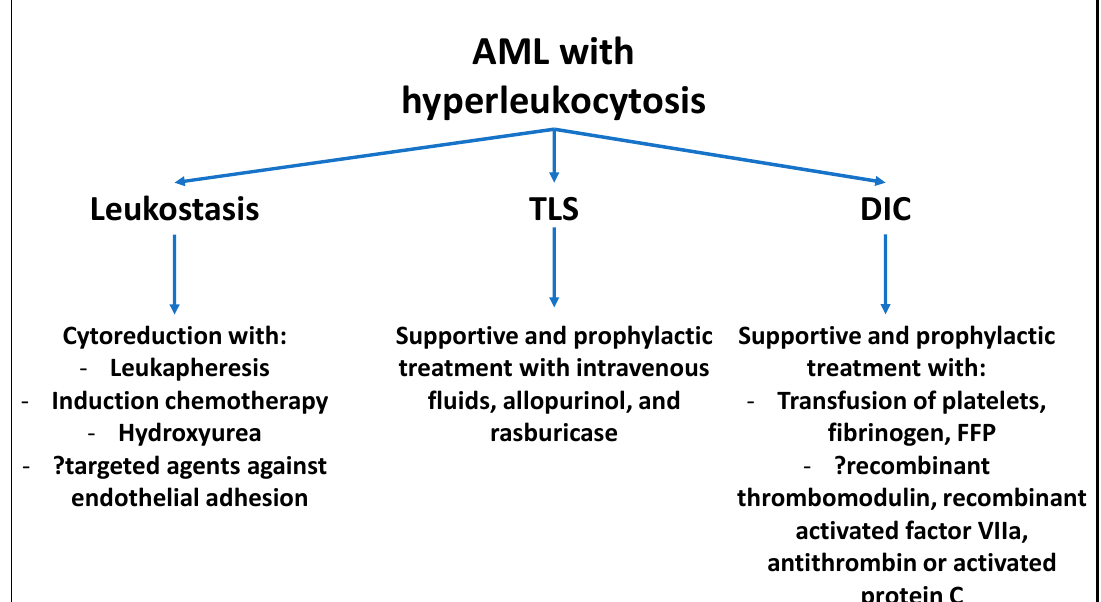
Figure 1. Current and potential future treatment options for complications of hyperleukocytosis in AML: Hyperleukocytosis is associated with a higher rate of leukostasis, tumor lysis syndrome (TLS), and disseminated intravascular coagulation (DIC). Current treatment options for leukostasis include mechanical removal of leukemic blasts with leukapheresis and cytoreduction with chemotherapy or hydroxyurea. As adhesion of leukemic cells to the endothelium is essential to the pathophysiology of leukostasis, targeting blast-endothelial cell interactions might become a future therapeutic strategy. TLS in AML is due to rapid cell turnover leading to electrolyte imbalances and increased serum levels of uric acid that can culminate in renal failure and fatal cardiac arrhythmias. Treatment of TLS entails supportive management of electrolytes, intravenous fluids to maintain urine output, and allopurinol or rasburicase to reduce the production of uric acid. DIC can be managed with transfusion of platelets, fibrinogen, and fresh frozen plasma (FFP). In sepsis-associated DIC as well as in small studies of AML patients, heparin, recombinant thrombomodulin, and other agents have been tested with mixed results and are not part of routine management of DIC associated with AML.